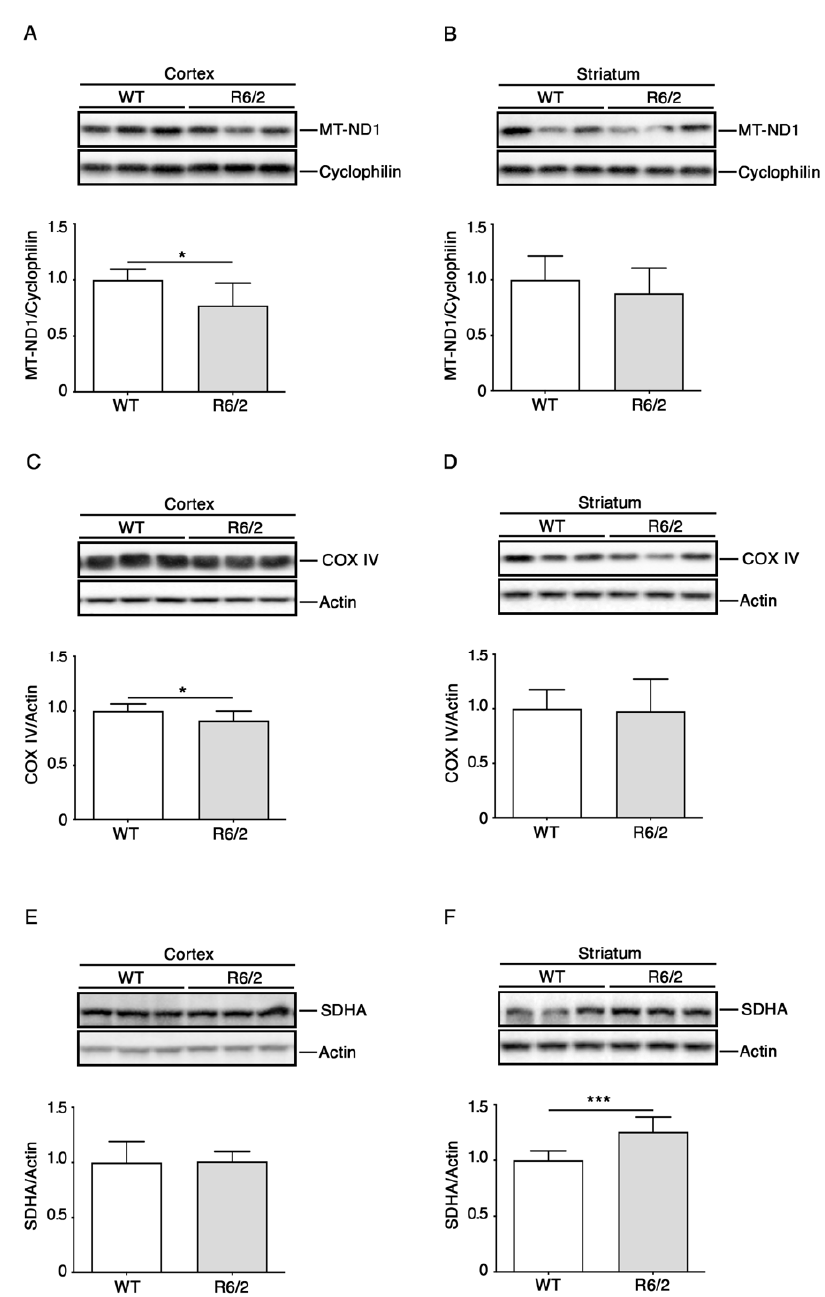
Figure 3. Altered protein levels of components of mitochondrial ETS in R6/2 brain. Representative cropped immunoblotting and densitometric analysis of MT-ND1 ( A , B ), COX IV ( C , D ) and SDHA ( E , F ) in cortical and striatal tissues from 11-week-old R6/2 mice and WT controls. N = 7 for each group of mice. Data are represented as mean ± SD. *, p < 0.05; ***, p < 0.001 (Unpaired t -test). The raw data used for generating the figure are reported in Supplementary Materials Table S3.